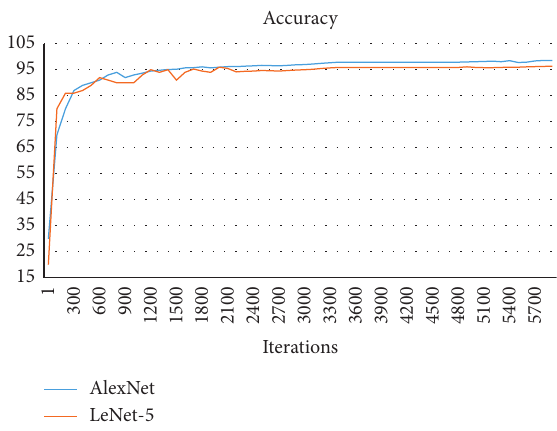
Figure 4: Performance comparison of both LeNet-5- and AlexNet- based models in Accuracy at every iteration.